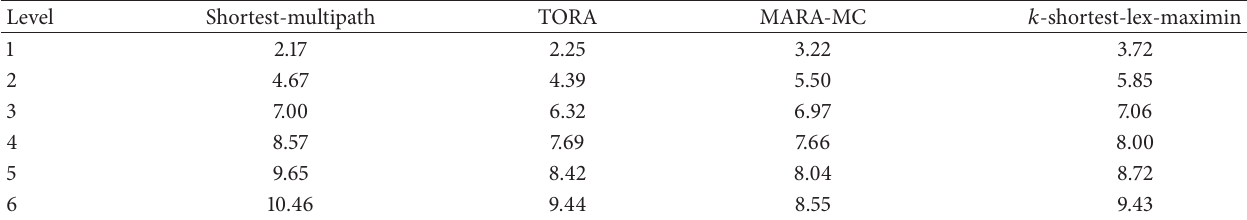
Table 1: Comparison of four tested algorithms: average number of paths per node at different levels 1–6 for 50-node networks. Levels (1–6) were present in most (47–50 out of 50) networks.